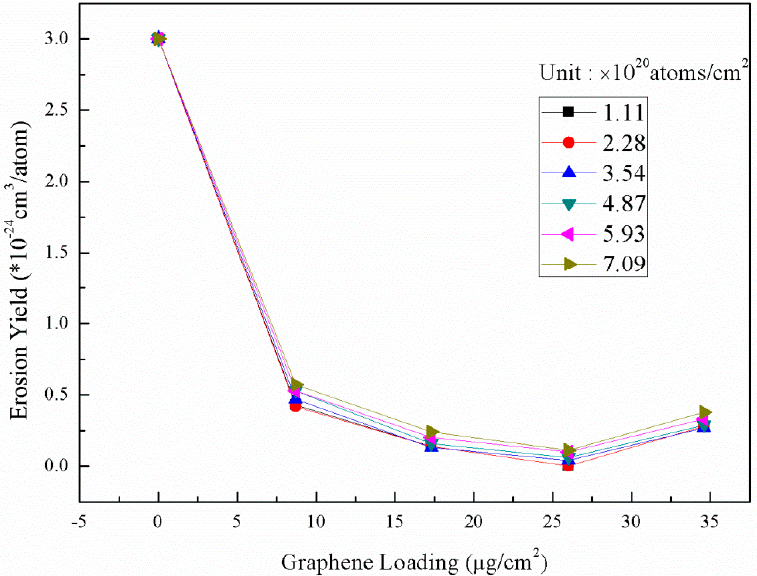
Figure 8. Erosion yield of coated Kapton with different graphene loadings in the AO exposure experiment.